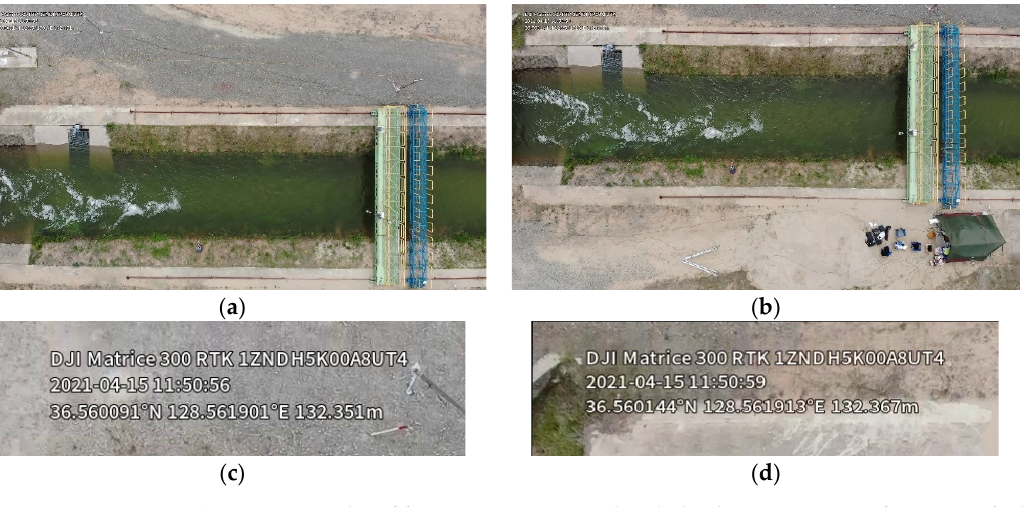
Figure 5. Examples of frame images captured with the drone camera: ( a ) frame 180; ( b ) frame 269; ( c ) top ‐ left area of frame 180; ( d ) top ‐ left area of frame 269.